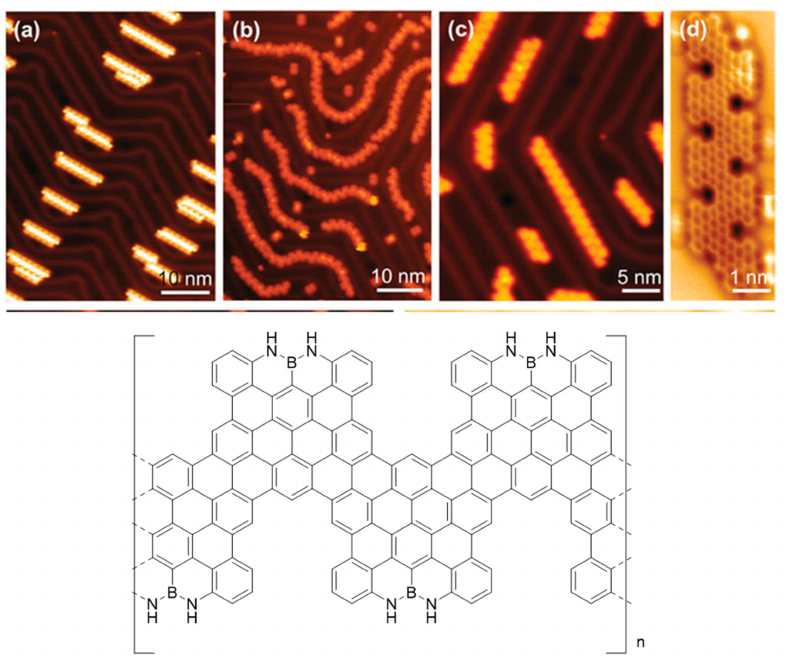
Figure 6. ( a ) STM image of 147 as sublimed on Au (111). ( b ) STM image of 147 after annealing at 200 ◦ C on Au (111), inducing deiodination and polymerization. ( c ) STM image of 147 after annealing at 450 ◦ C on Au (111). ( d ) nc-AFM image of the polymer. (Reproduced with permission from Y. Fu et al., Angewandte Chemie International Edition; published by German Chemical Society (GDCh), 2020.